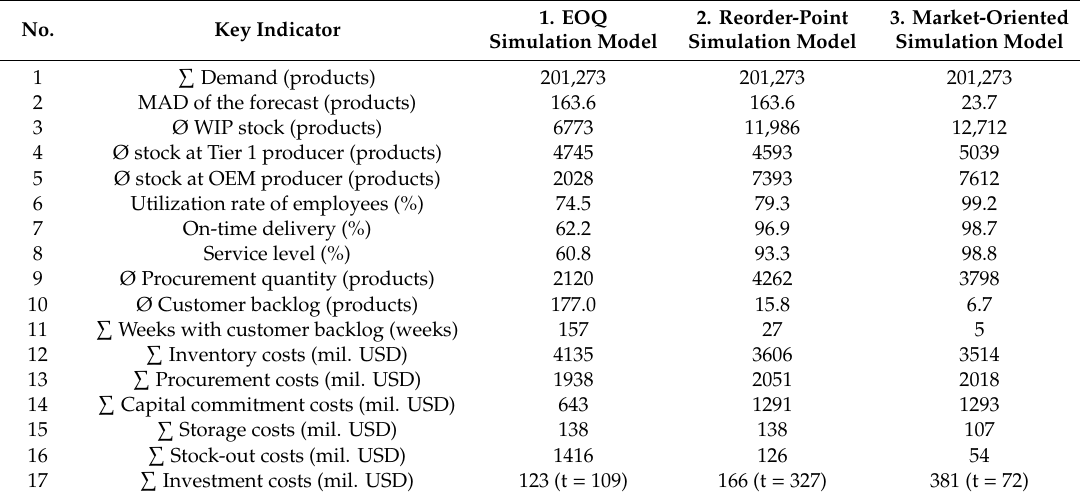
Table 10. Simulation results for the second demand